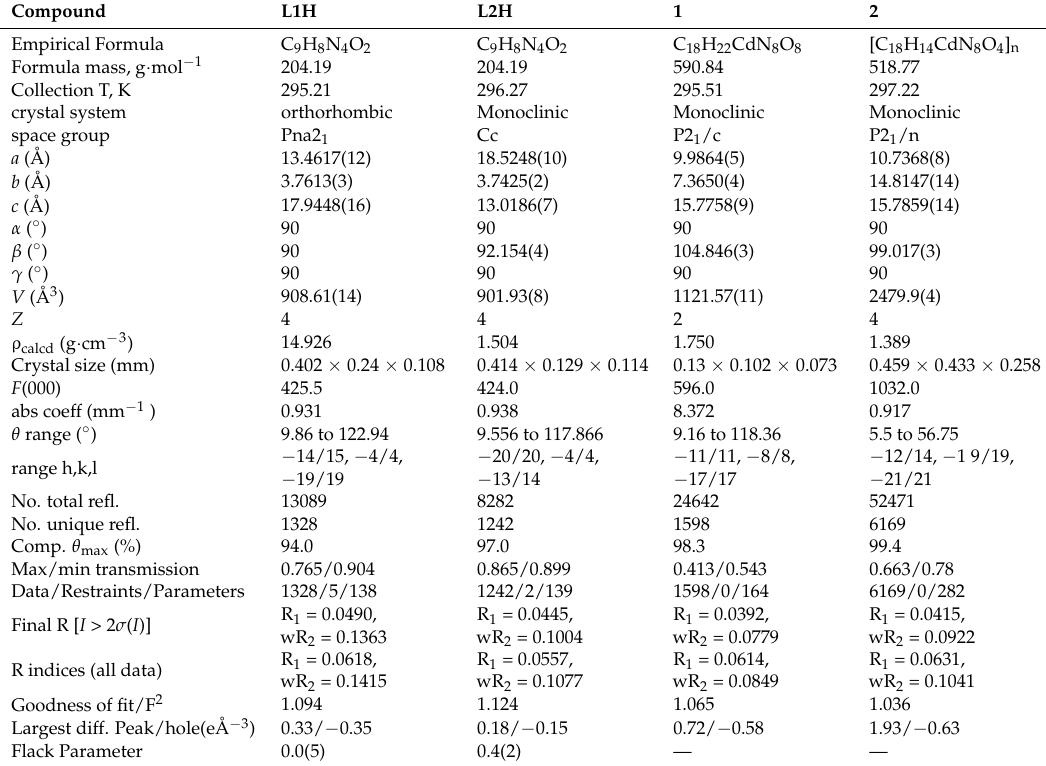
Table 1. Crystal data parameters for compounds L1H , L2H , 1 , and 2